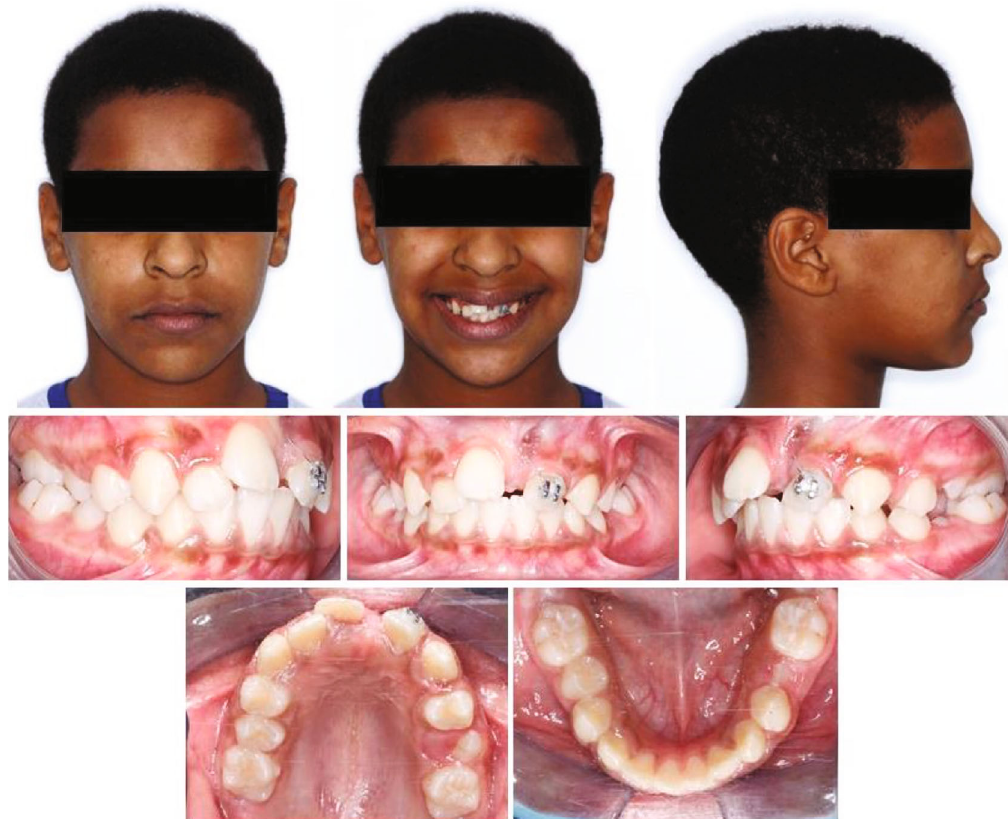
Figure 1: Pretreatment extra- and intraoral photographs.